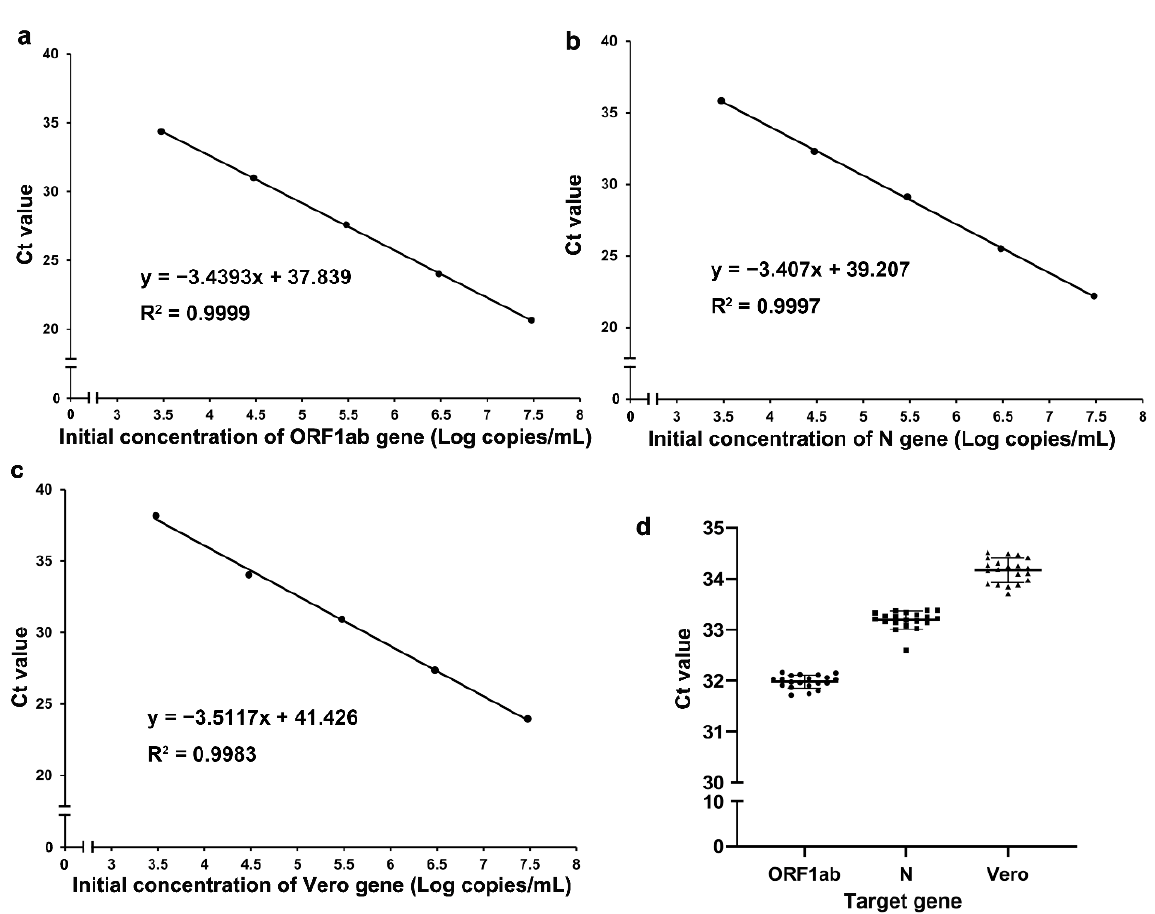
Figure 2. The amplification efficiency and precision of the ORF1ab, N, and Vero genes. ( a ) Analysis of the amplification efficiency of the ORF1ab gene; ( b ) analysis of the amplification efficiency of the N gene; ( c ) analysis of the amplification efficiency of the Vero gene; ( d ) scatter plots based on the Ct values of the ORF1ab, N, and Vero genes.